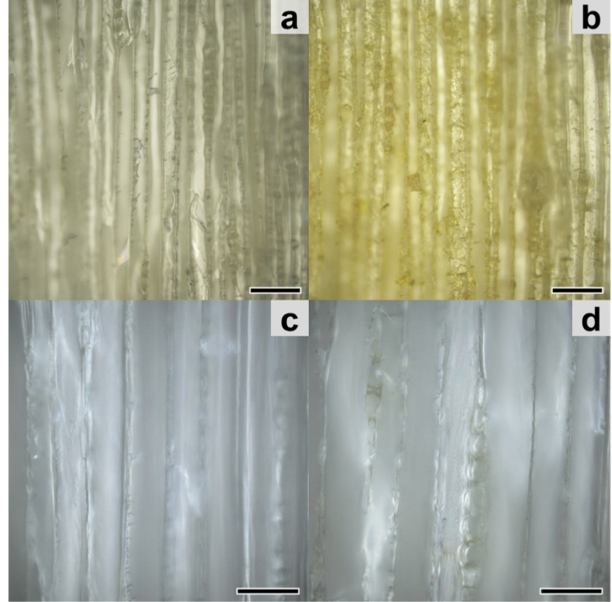
Figure 5. CLSM micrographs of untreated ( a , c ), HWE-treated ( b ) and KWE-treated ( d ) tangential sections of Scots pine sapwood ( Pinus sylvestris ). Magnifications of 10×, 20× and 50×.